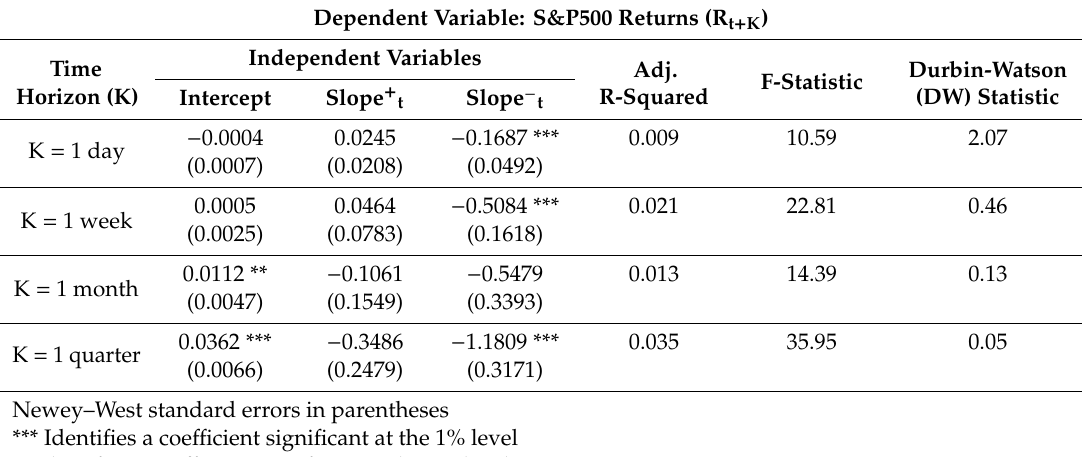
Table 2. The VIX futures term structure and future S&P500 returns